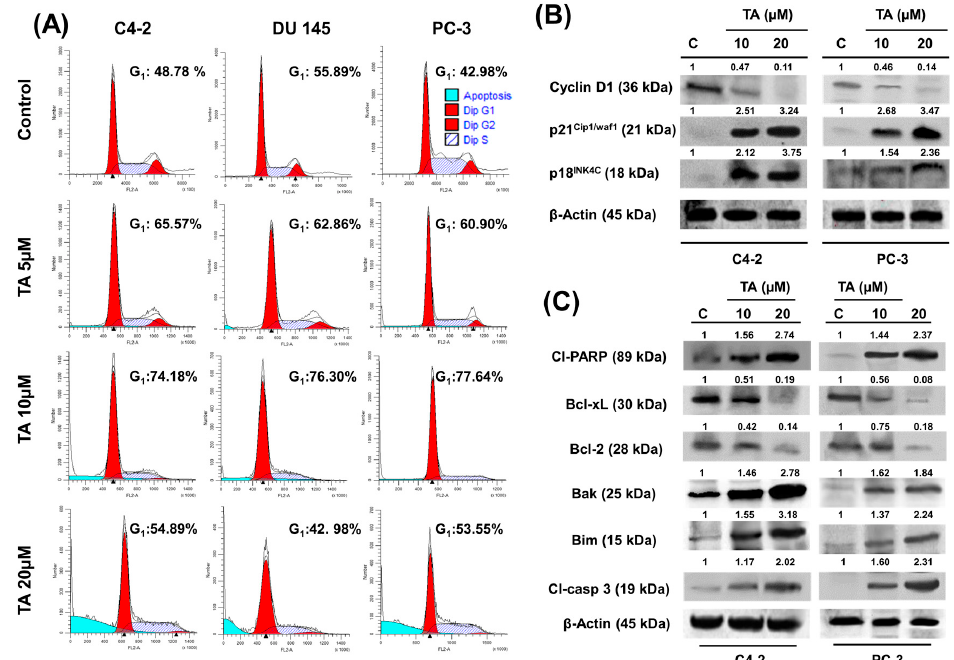
Figure 3. Tannic acid induces G 1 phase arrest and apoptosis in prostate cancer cells. Prostate cancer cells were treated with TA for 24 h and cell cycle analysis was performed by flow cytometer. ( A ) Histogram plot of C4-2, DU 145 and PC-3 cells after treatment of 5, 10, and 20 μ M TA. Untreated cells were used as control; ( B ) Directive role of TA on cell cycle regulatory proteins and its effect on G 1 phase arrest. Western blot analysis of G 1 phase cell cycle regulatory proteins in prostate cancer cells treated with TA. Tannic acid treated cell lysates were prepared and subjected for Western blot analysis. β -actin